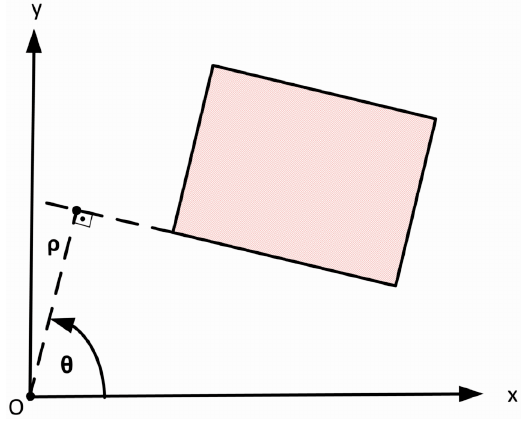
Figure 3. Parameters θ and ρ of a building outline in the xy -system.